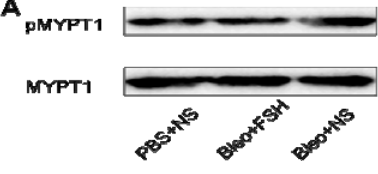
Figure 5. MYPT1 phosphorylation in the lung on day 21. The relative amounts of MYPT1 phosphorylation are expressed as pMYPT1/MYPT1+pMYPT1. Results are expressed as means ± SEM ( n = 6). Statistical analysis was performed using one-way ANOVA followed by Tukey’s multiple comparison test (* p <